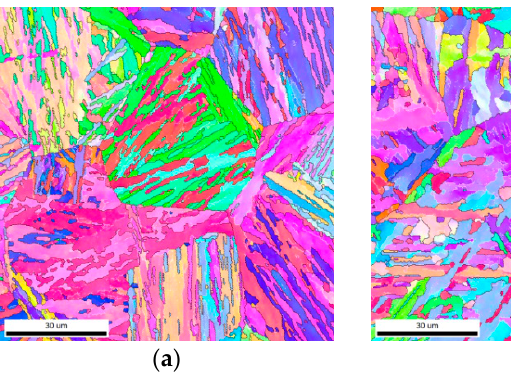
Figure 7. Prior austenite grain size at different heat input.